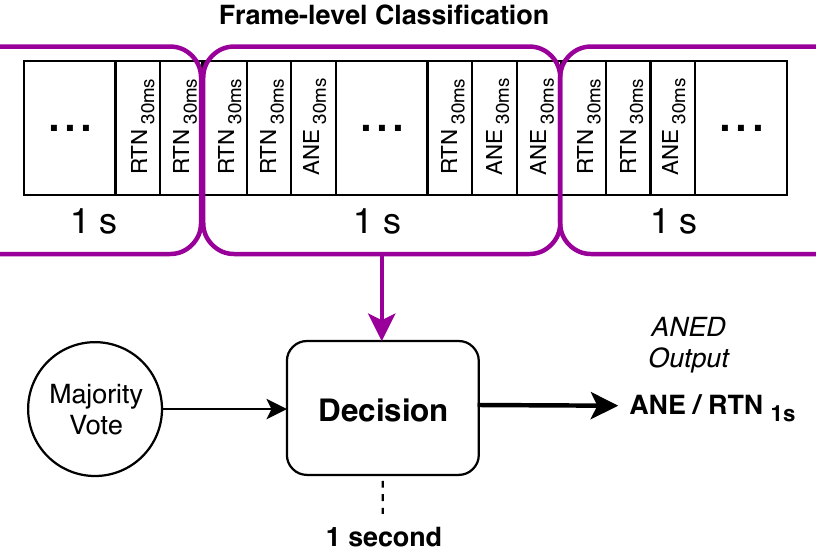
Figure 3: Block diagram of the majority vote stage applied after the frame-level classification, which outputs the ANED’s binary decision every second (RTN/ANE 1 s